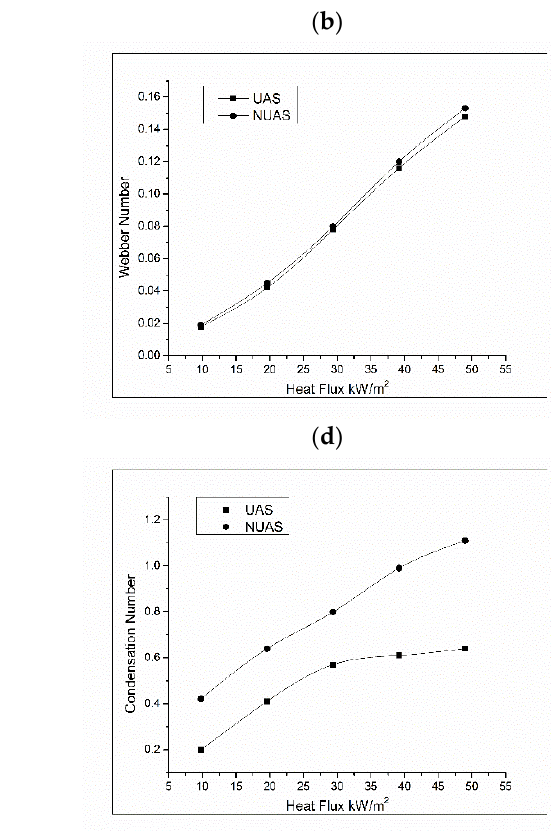
Figure 8. Non-dimensional numbers with heat fluxes ( a ) BO number, ( b ) WO Number, ( c ) Ku Number, ( d ) Co number.